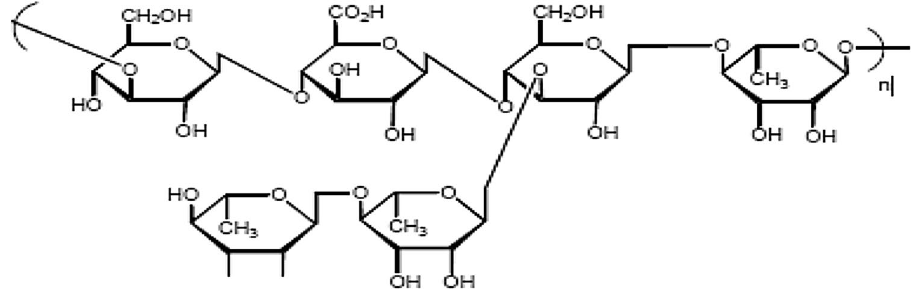
Fig. 1 Chemical structure of diutan